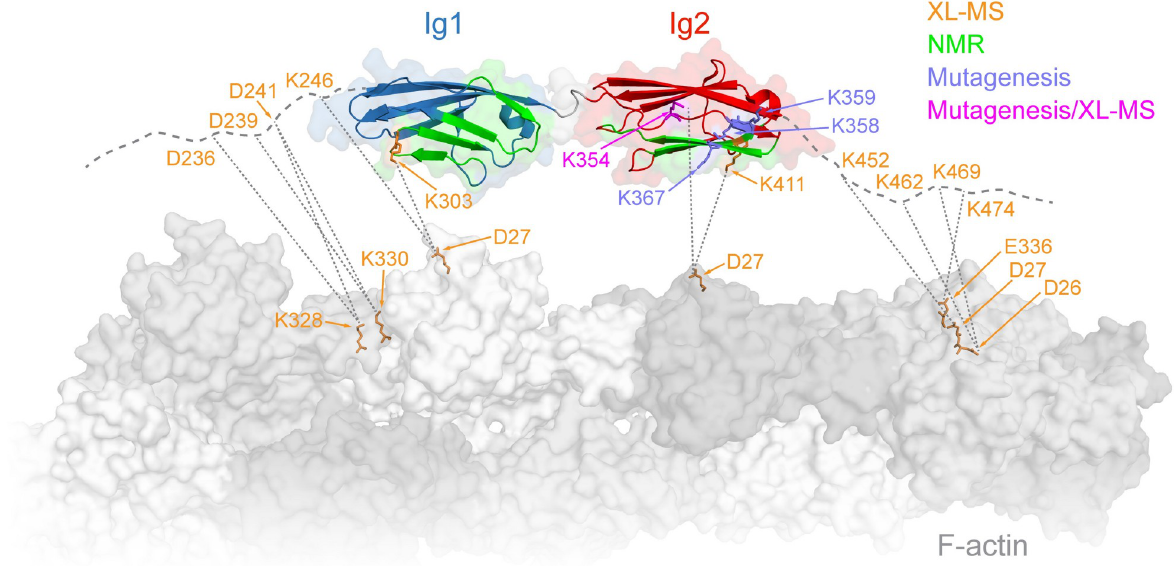
Fig 3. Integrative structural model of myotilin:F-actin complex. Summary of experimental data on myotilin:F-actin complex, obtained from XL-MS (orange), mutagenesis/co-sedimentation analysis (medium slate blue), and NMR (green). K354 was found to be involved in the interaction by both XL-MS and mutagenesis/co-sedimentation analysis (magenta). Thick, gray dashed lines represent N-terminal and carboxyl-terminal flanking regions of myotilin Ig domains. Selected residues found in cross-links between actin and myotilin are shown in orange. NMR, nuclear magnetic resonance; XL-MS, cross-linking coupled to mass